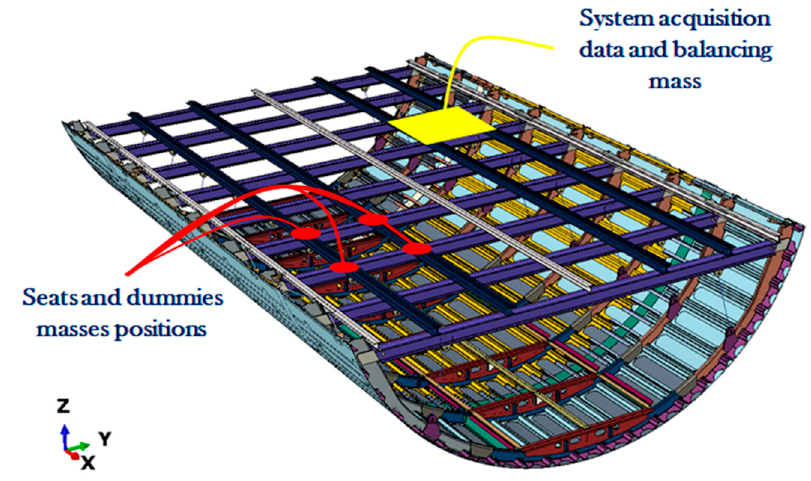
Figure 5. Position of seat dummies and added masses balancing.